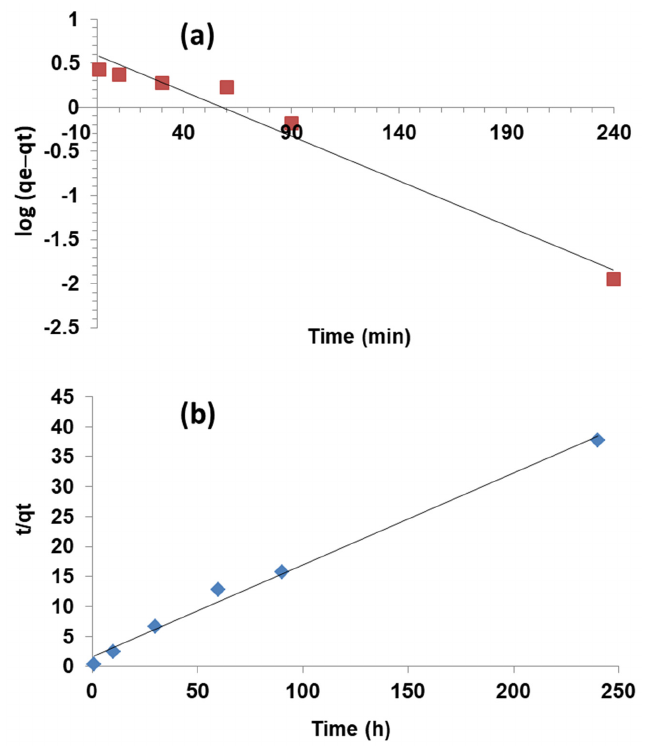
Figure 2. Kinetic modeling data of As(V) adsorption using peanut shell biochar: ( a ) PFO; ( b ) PSO. Table 1. Kinetic model parameter data for egg shell biochar.